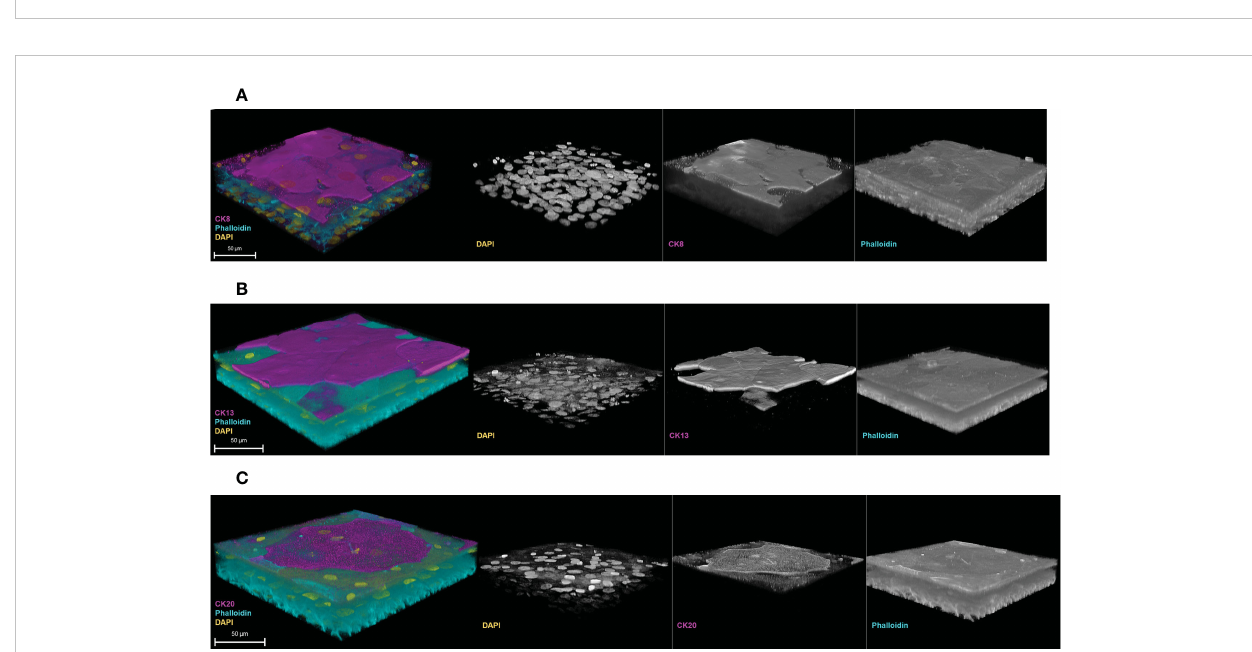
FIGURE 4 Cytodifferentiation in the 3D-UHU model. 3D confocal image of (A) CK8 (magenta) expressed throughout the layers; (B) CK13 (magenta) expressed at the late/terminal differentiated intermediate cell layers, and (C) CK20 (magenta) expressed at the terminally differentiated umbrella-like cells. Phalloidin-stained F-actin is presented in cyan and DAPI-stained DNA is presented in yellow; scale bars are as shown. Images are representative of at least three biologically independent